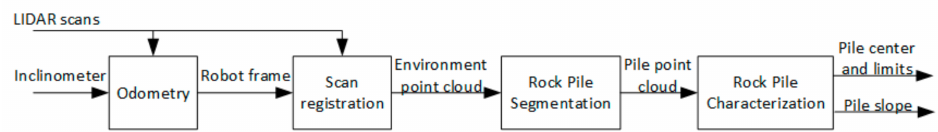
Figure 7. Rock pile identification block diagram. LIDAR odometry and machine’s inclinometer data are used to register 2D laser scans into a 3D model of the environment. A segmentation of the rock pile is then carried out, and its center, limits, and slope are